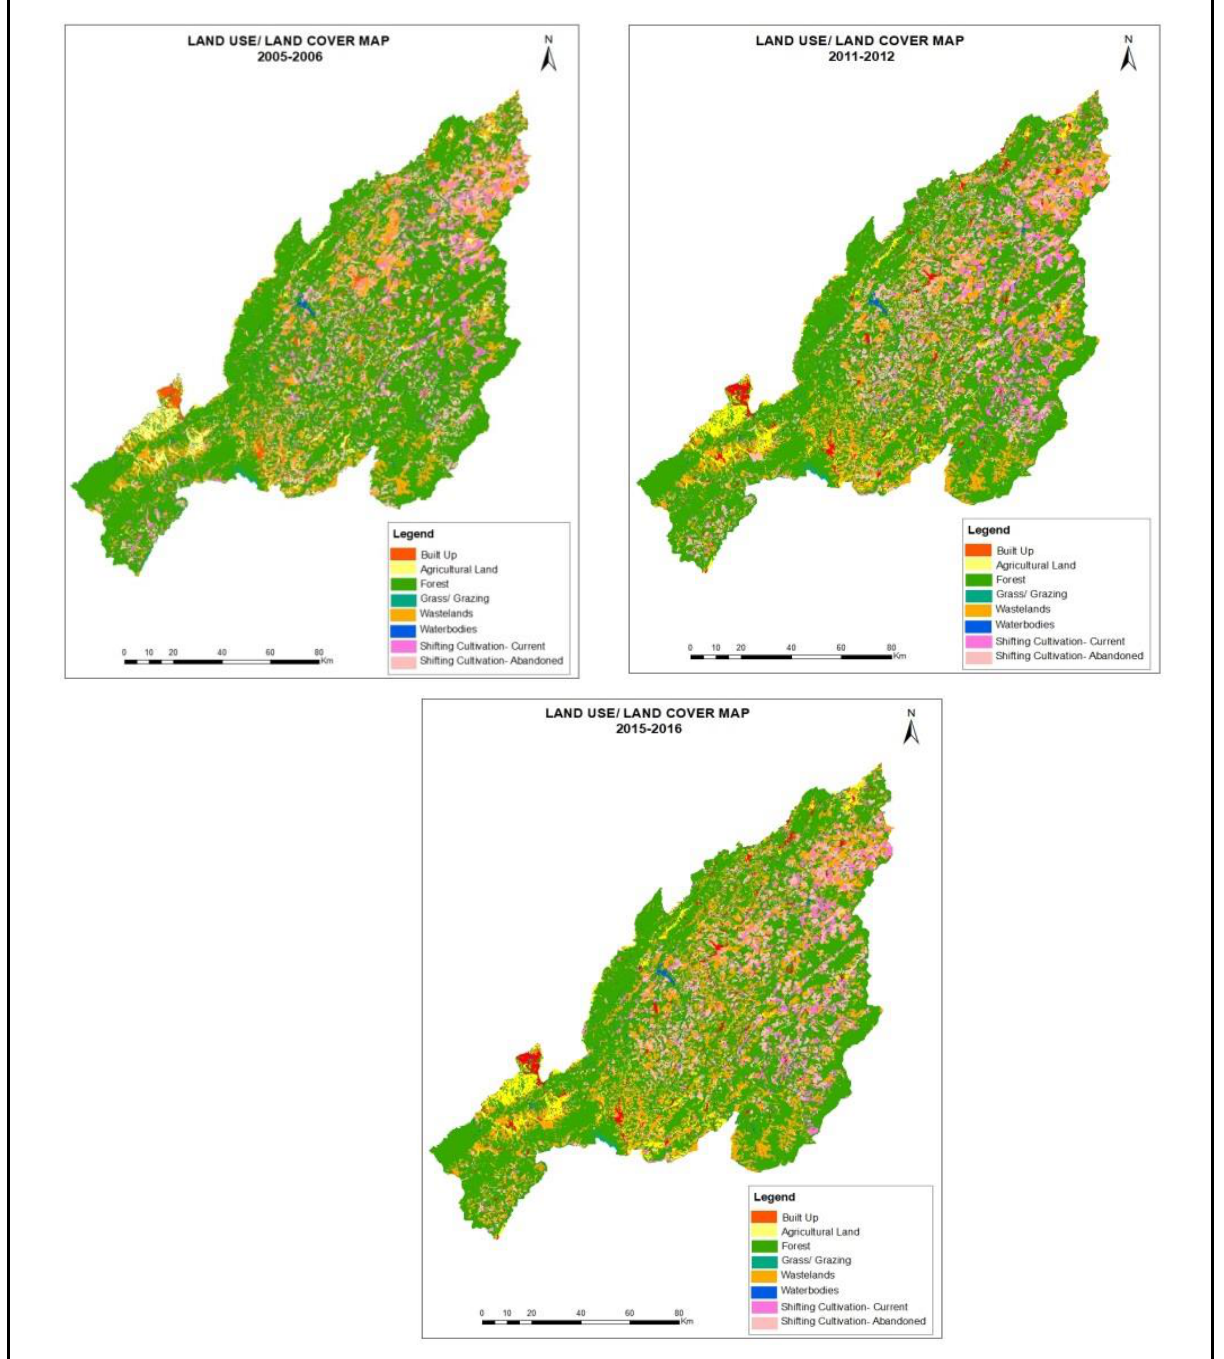
Figure 3: Land use map of 2005-06, 2011-12,